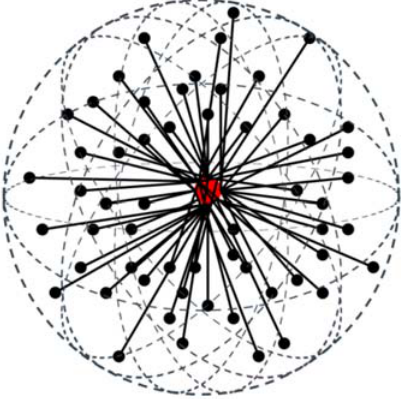
Figure 6. Scattering of the particles along the radii [39].